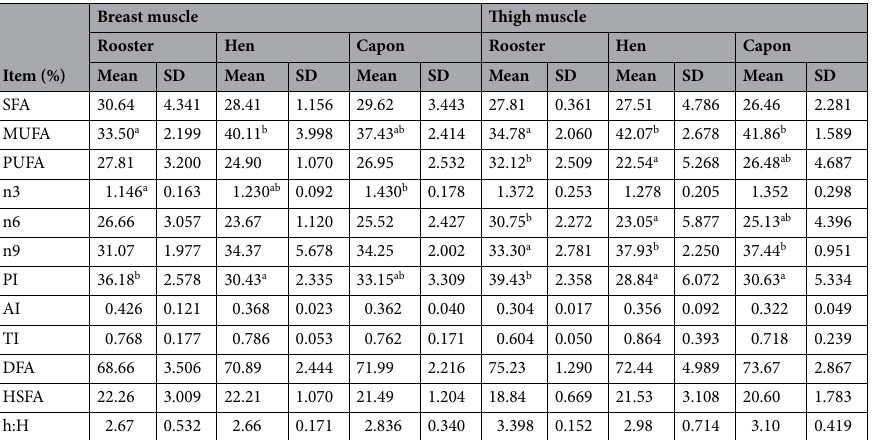
Table 4. Fatty acid indexes of analysed muscles. a,b Mean values in the row (among particular muscle) differ significantly at p ≤ 0.05; SD standard deviation, SFA saturated fatty acids, UFA unsaturated fatty acids, PUFA polyunsaturated fatty acids, MUFA monounsaturated fatty acids, PI peroxidizability index, AI atherogenicity index, TI thrombogenic index, DFA desirable fatty acids, HFSA hypercholesterolaemic saturated fatty acids, h/H hypocholesterolaemic/hypercholesterolaemic